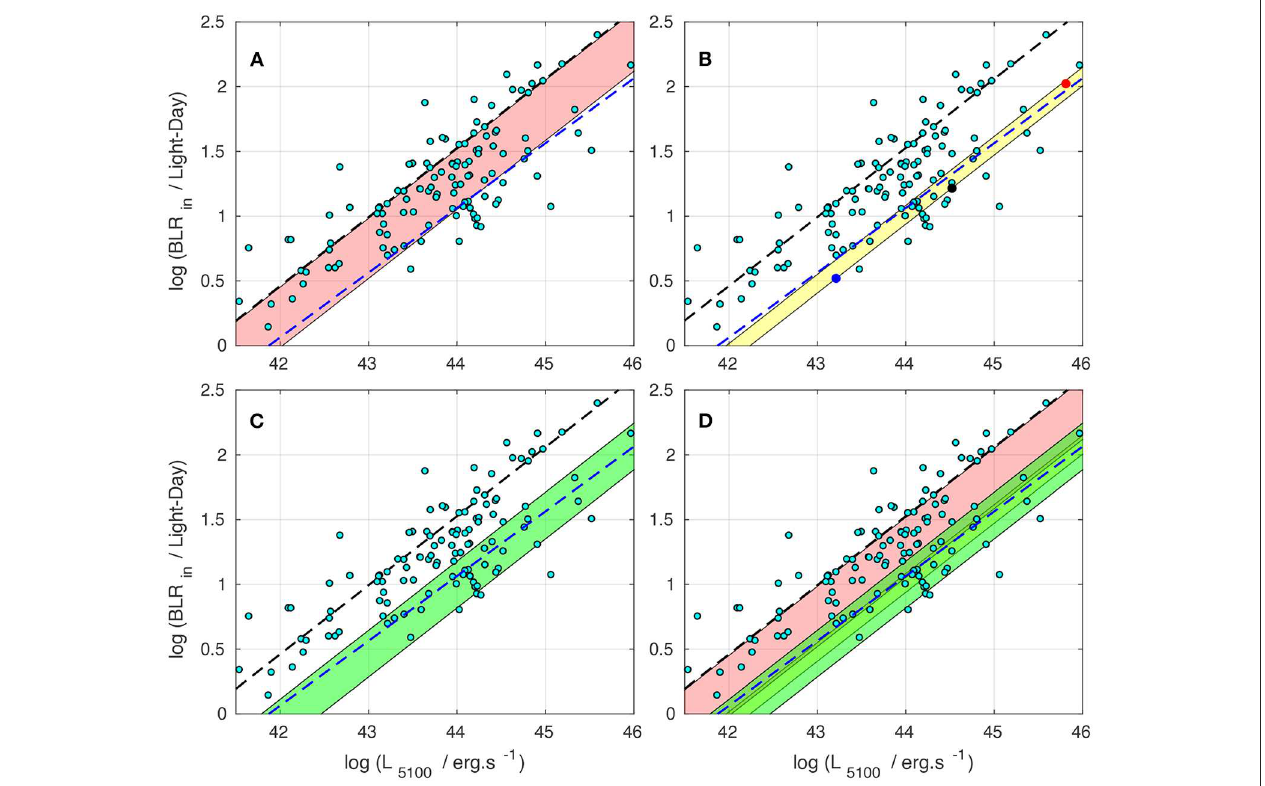
FIGURE 3 | RL relation (considering the Bentz et al., 2013 relation’s slope) based on all reliable time-delays obtained from numerical FRADO for all shielding cases and Eddington rates of 0.01 (A) , 0.1 (B) , 1 (C) , blackhole mass of 10 8 M ⊙ , and viewing angle of 39.2 degree. (D) Shows the overlap of all Eddington rates. The shaded areas cover the range between the minimum and maximum reliable time-delays obtained per each Eddington rate. Points in cyan show a sample of observational data from Martínez-Aldama et al. (2019). The blue dashed line represents the RL relation predicted by analytical FRADO. The black dashed line shows the RL relation calibrated for sources with low Eddington ratios by Bentz et al. (2013). Three specific solutions for α = 2.0 and accretion rate of 0.1 are shown as points in panel (B) with the blue, black, and red points corresponding to blackhole mass of 10 7 , 10 8 , 10 9 M ⊙ , respectively.